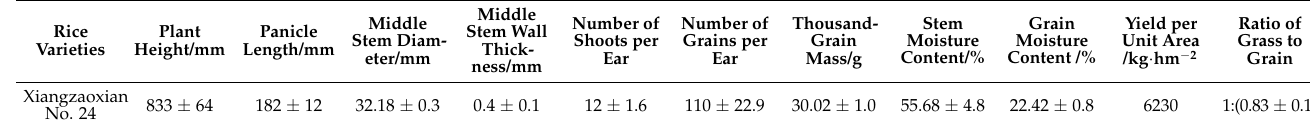
Table 1. Main physical characteristic parameters of harvesting rice.